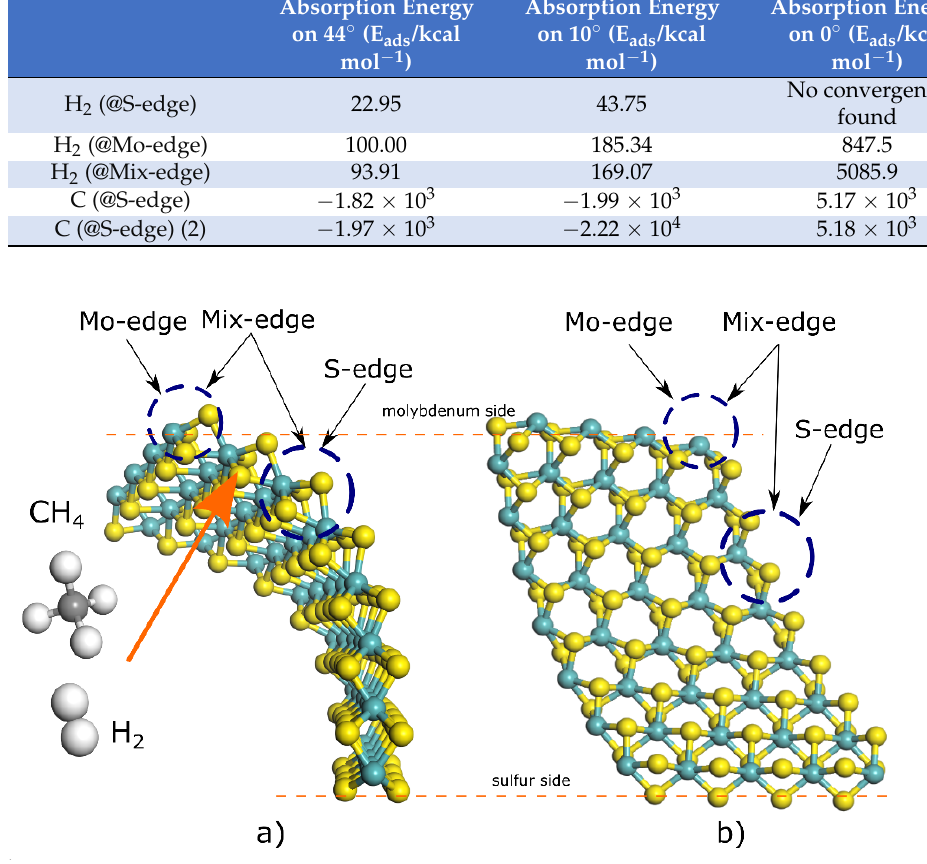
Figure 5 . Schematic diagram for 2H ‐ MoS 2 layer bent at 44° and selected sites for hydrogenation and carburization using H 2 and CH 4 as hydrogen and carbon sources. Color code: White is hydrogen, and gray is carbon. ( a ) The side view (101) of 2H ‐ MoS 2 layer bend at certain angle to indicate the Mo and S edge sites of adsorption. ( b ) The top view (002) of 2H ‐ MoS 2 layer bend at certain angle to indicate the Mo and S edge sites of adsorption. Table 3 . Comparison of computed adsorption energy of hydrogen (H 2 ) on S ‐ edge, S ‐ Mo ‐ edge, and Mix ‐ edge sites between 2H ‐ MoS 2 slabs with 10° and 44° and 0° bending.